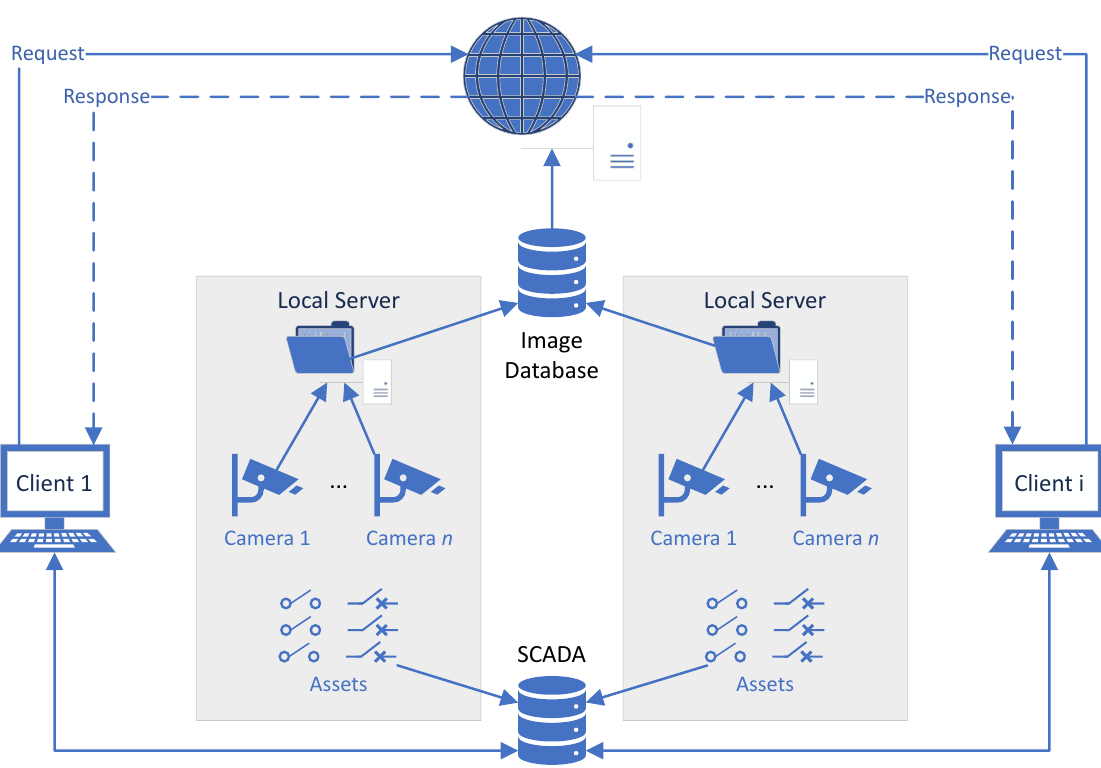
Figure 5. Augmented virtuality system architecture.